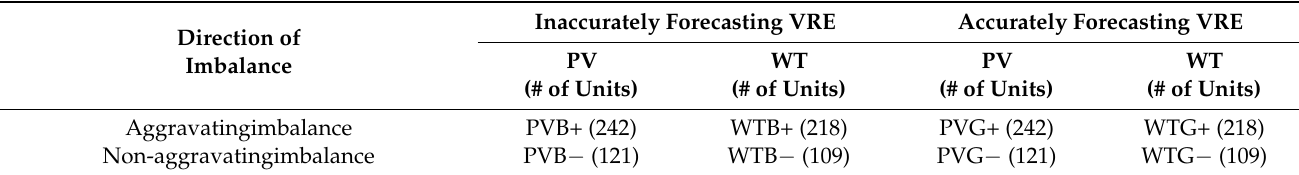
Table 1. Group of VREs participating in the wholesale